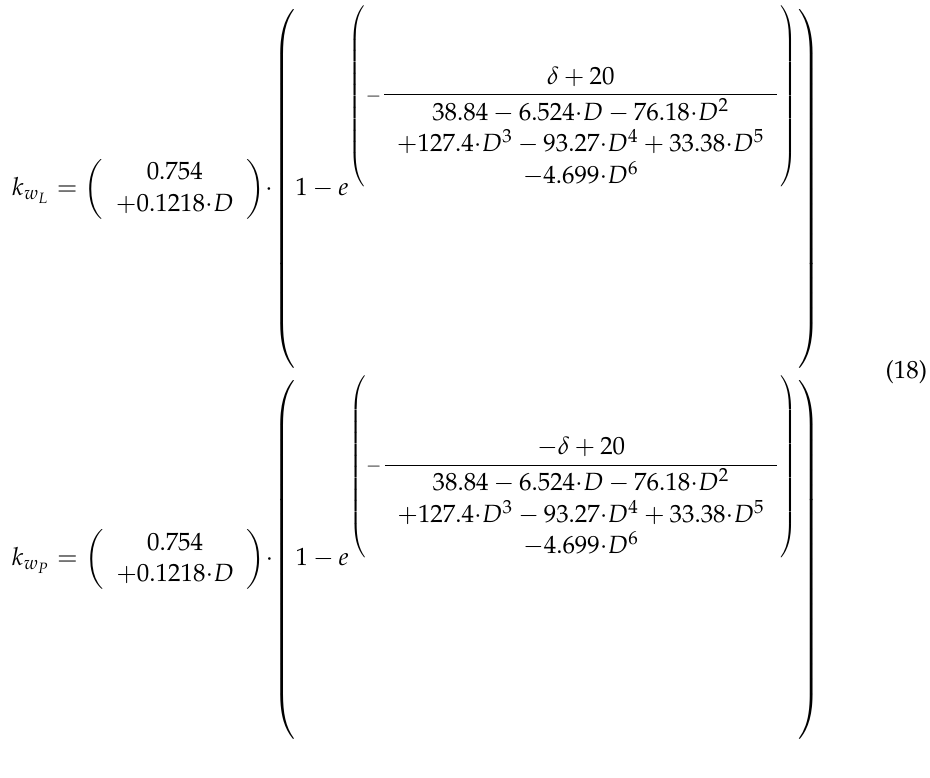
Figure 13. Cross-sections of multiples of the maximum speed of the left engine along the δ axis from fuzzy controller and the approximated course by exponential function.